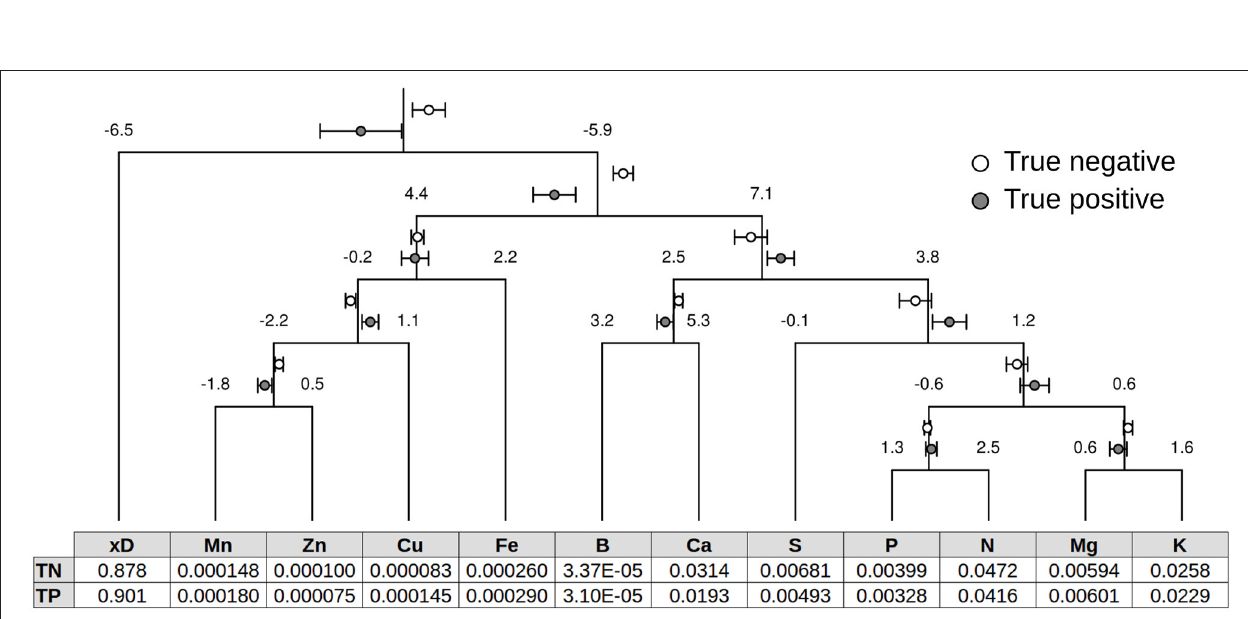
Frontiers in Plant Science | www.frontiersin.org